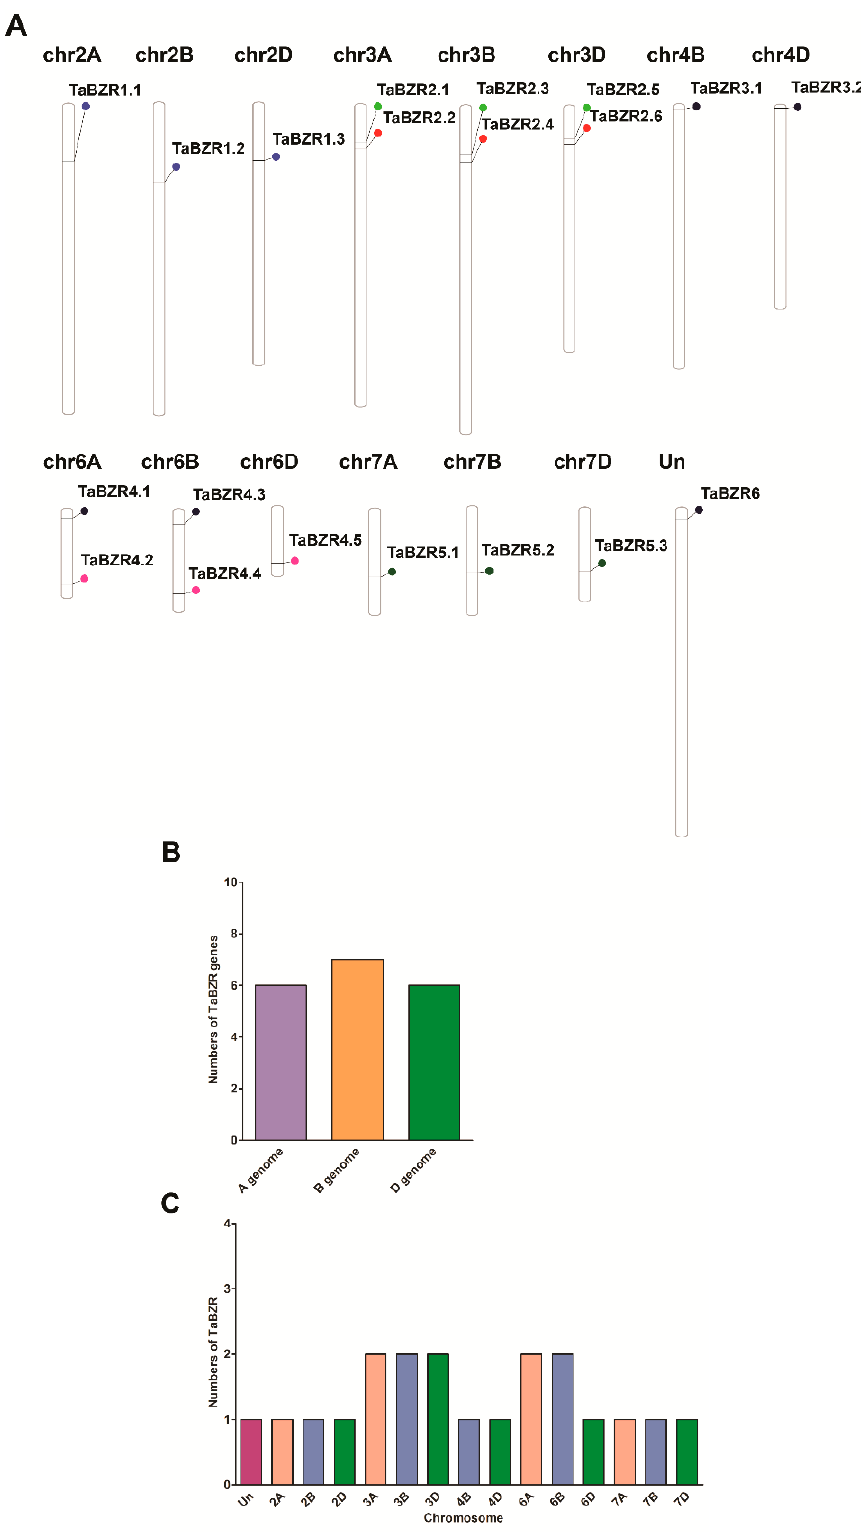
Figure 2. Genomic distribution of identified BZR genes on the 21 chromosomes of wheat and within the 3 subgenomes. ( A ) Schematic representations of the chromosomal distribution of BZR genes on the 21 chromosomes of wheat and the name of the gene on the right side. The colored circle on the chromosomes indicates the position of the BZR genes. The chromosome numbers of the three subgenomes are indicated at the top of each bar. ( B ) Distribution of BZR genes in the three subgenomes. ( C ) Distribution of BZR genes across 21 chromosomes.